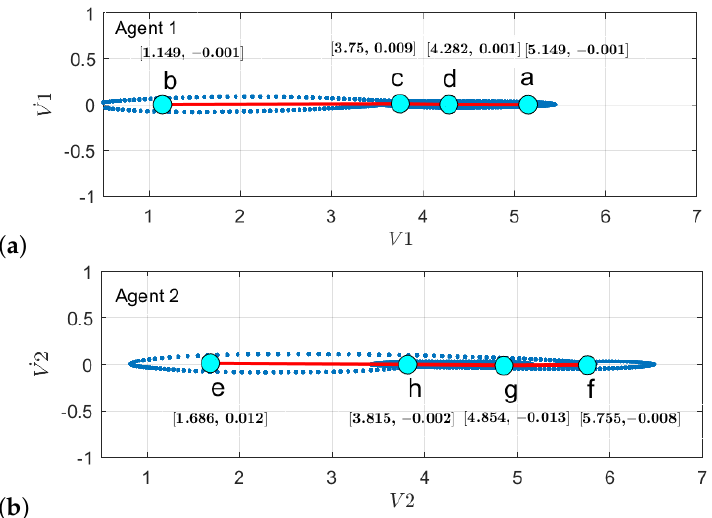
Figure 21. Clustering of GEs from incrementally learned model M 2 for ( a ) agent 1 and ( b ) agent 2 . The transition probability matrix for ego-thing 1 has been updated as shown in Figure